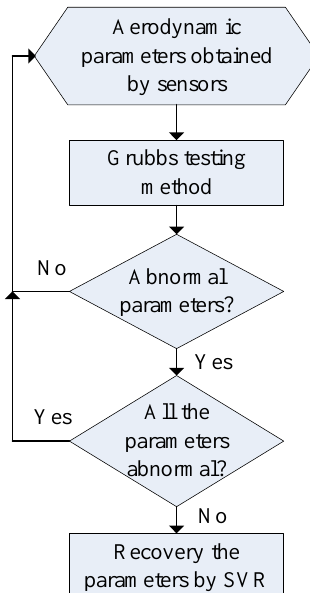
Figure 9. Processing steps for outliers.